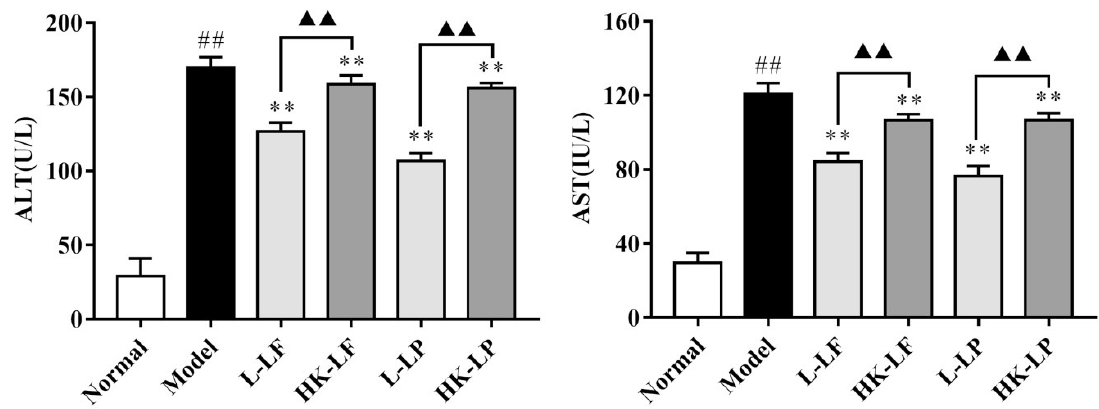
Figure 5. The levels of liver enzymes in serum. ## p < 0.01 compared with the normal group, ** p < 0.01 compared with the model group, and ▲▲ p < 0.01.